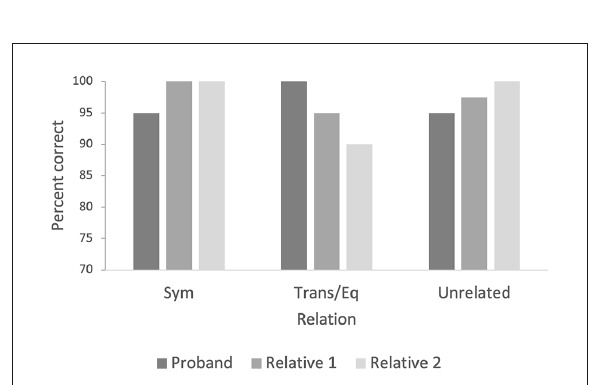
FIGURE4 The figure indicates the percentage of correct responses for symmetry, transitivity/equivalence, and unrelated pairs for the priming test with images. Note. BP, baseline probes; Sym, symmetry; Trans, transitivity; Eq, equivalence. both), and transitivity/equivalence (average 96.6%: 100% for relative 1 and 93.3% for relative 2).